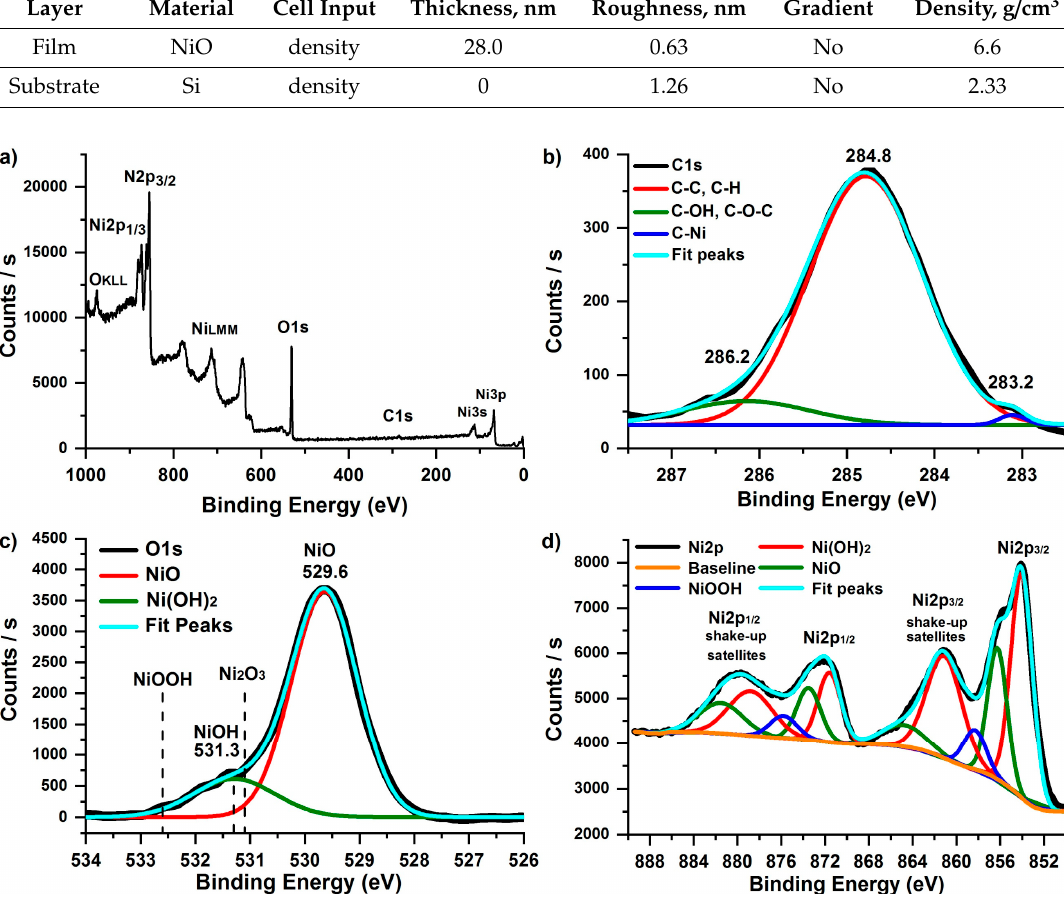
Figure 4. XPS survey ( a ), C1 s ( b ), O1 s ( c ), and Ni2 p ( d ) spectra of NiO thin film deposited on silicon substrates using NiCp 2 and O 2 plasma at 300 °C during 2300 ALD cycles.